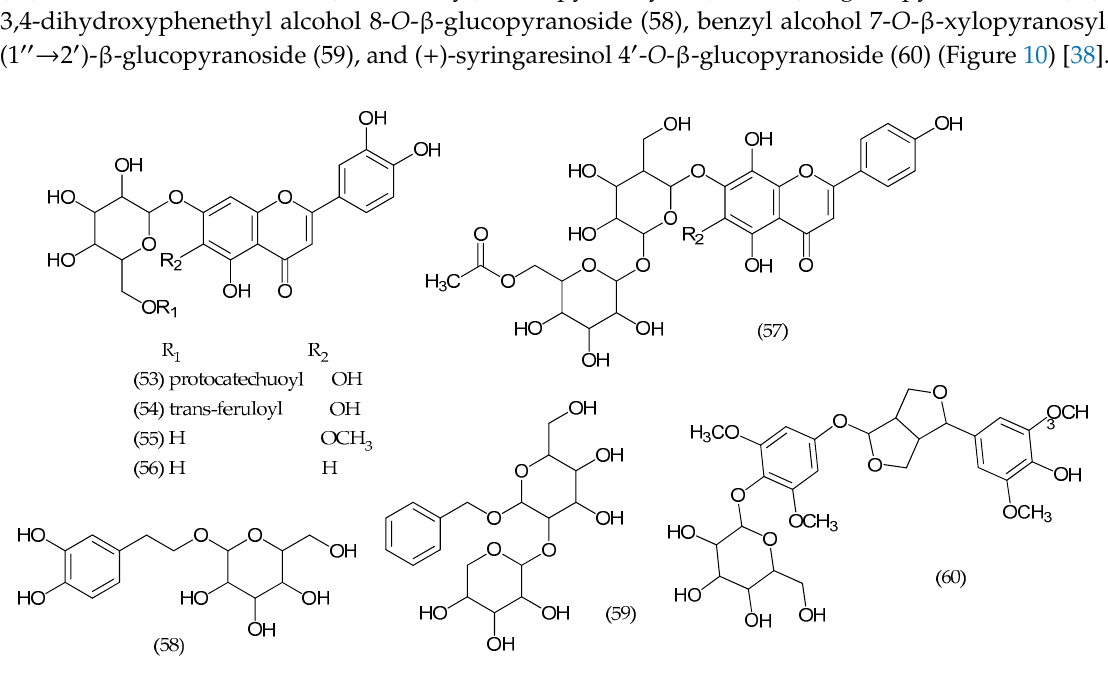
Figure 10. Phytoconstituents from Veronica thymoides .